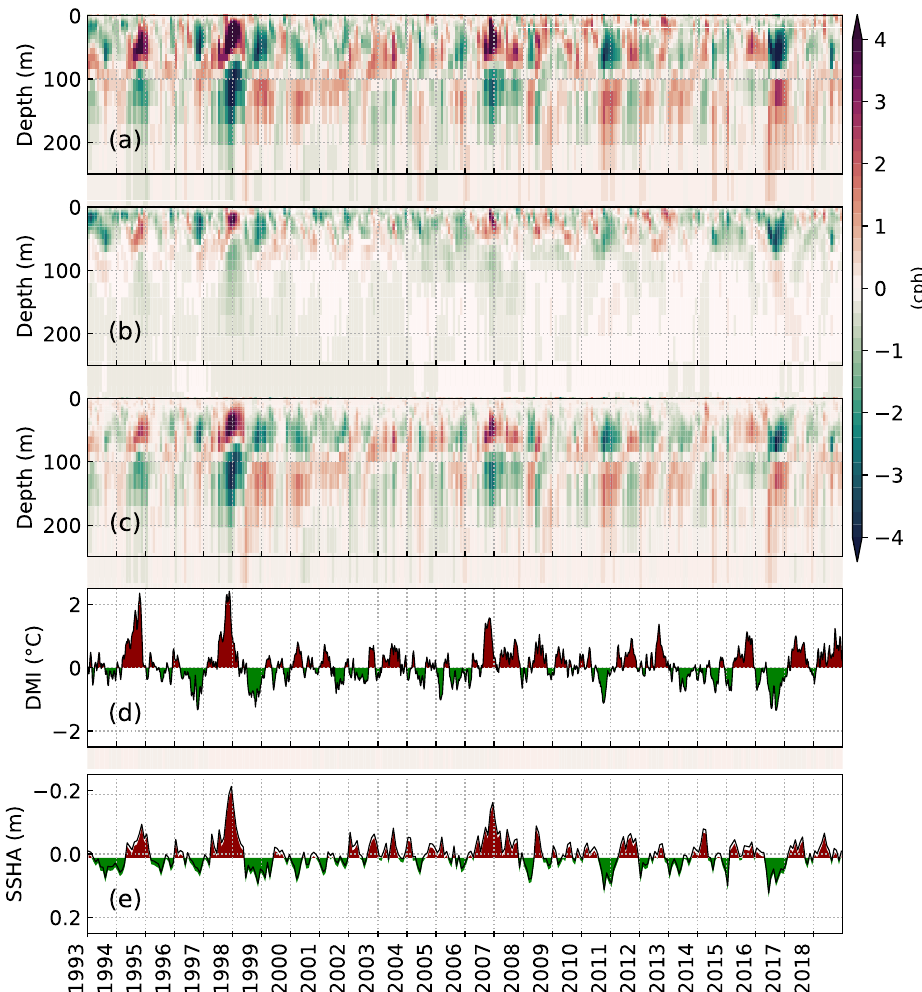
Figure 3. ( a ) Time-series of buoyancy frequency anomaly (after removing the annual cycle). ( b ) Time-series of buoyancy frequency anomaly due to salinity changes. ( c ) Time-series of buoyancy frequency anomaly due to temperature changes. ( d ) Time-series of DMI (3-month rolling mean) representing the IOD. ( e ) Time series of the detrended SSHA after subtracting the annual cycle. Domain-averaged (4°–17° N, 92°–99° E) values derived from ORAS5 are considered in ( a – c ) and ( e ) to represent the Andaman